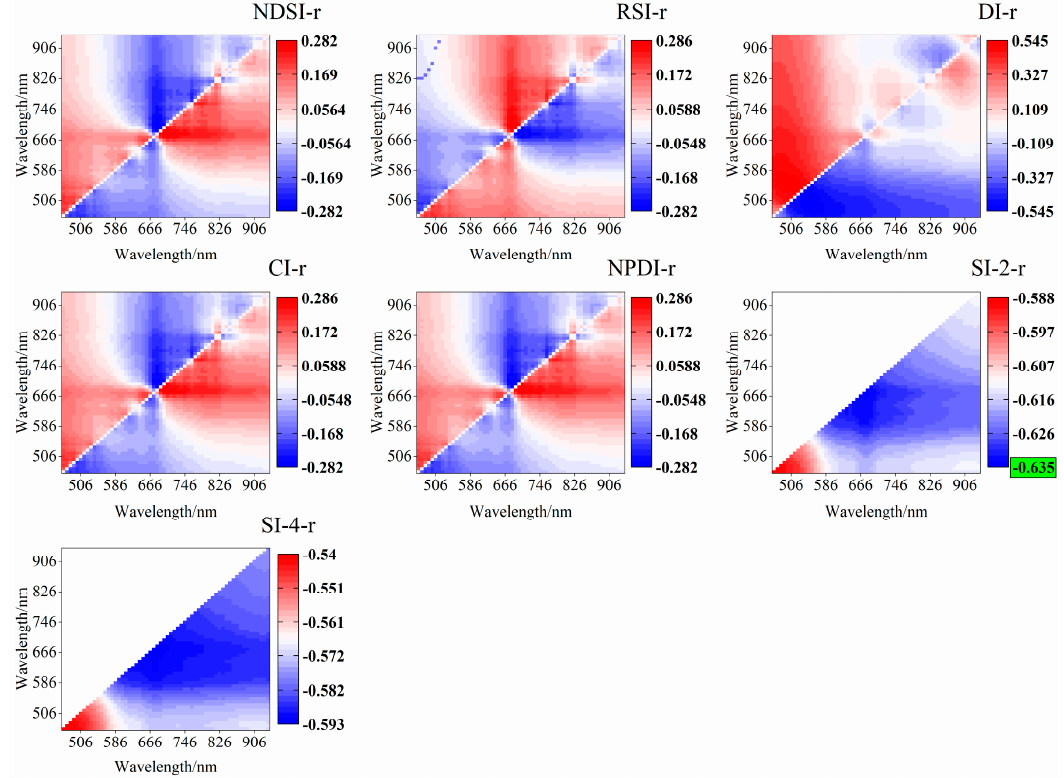
Figure 12. Two-dimensional r diagram of SMC and original spectrum of 466–938 nm.